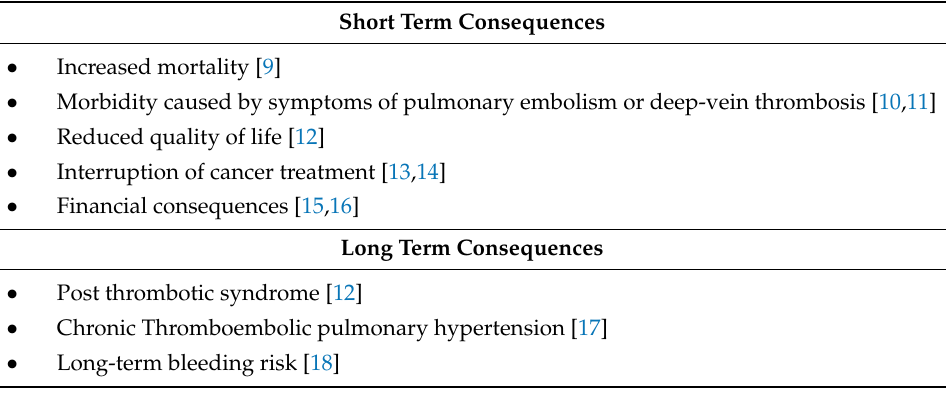
Table 1. Why VTE should be prevented in cancer